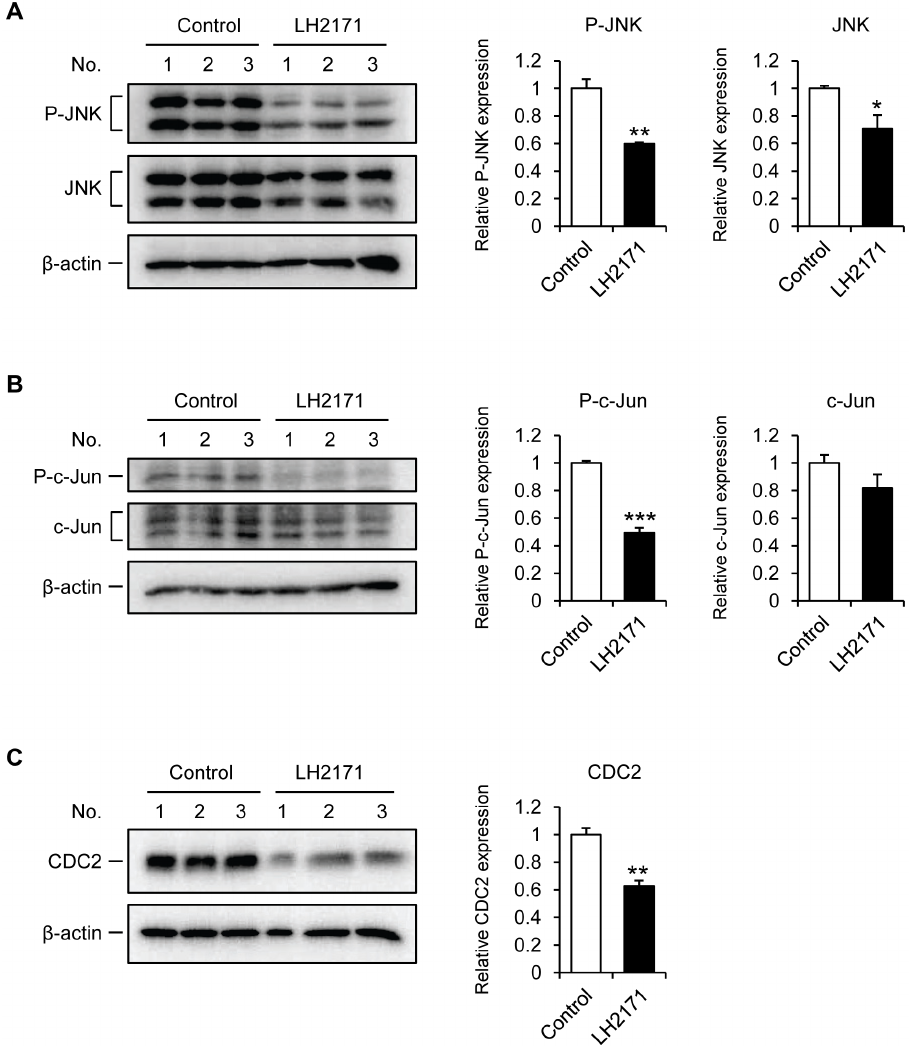
Figure 4. LH2171 reduced CDC2 expression through the suppression of c-Jun N-terminal kinase (JNK) signaling pathway in BJAB cells. BJAB cells were cultured in the presence or absence of Lactobacillus helveticus SBT2171 (LH2171) (100 m g/mL) for 72 hours. The cell lysates were analyzed by western blotting to detect the expression of phosphorylated and total protein of JNK (A), c-Jun (B), and CDC2 (C) in triplicate (indicated as 1–3 on the gels). Relative expression of each protein normalized by b -actin expression was quantitated. Data are expressed as means 6 SEM (n=3) and compared with the control (* P , 0.05, ** P , 0.01, *** P , 0.001) by Student’s t-test.